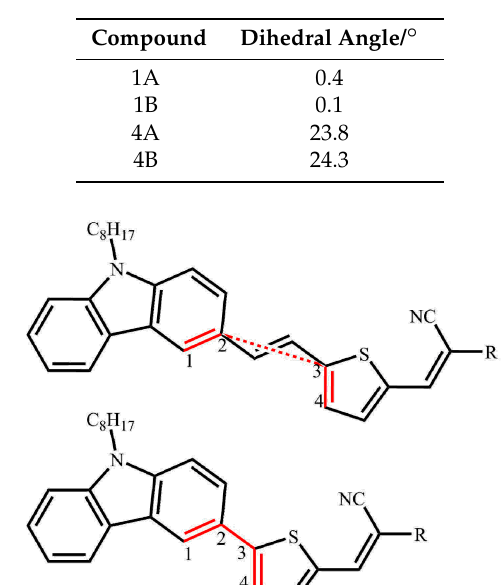
Table 2. Calculated values for the dihedral between carbazole and thiophene units for structures calculated at B3LYP level, for 1A / 1B and 4A / 4B , as assigned in Figure 4.